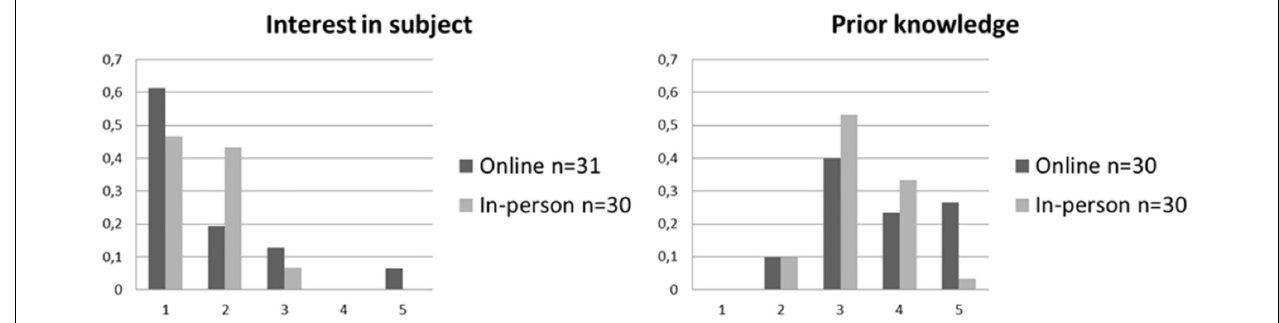
While synchronous online training cuts